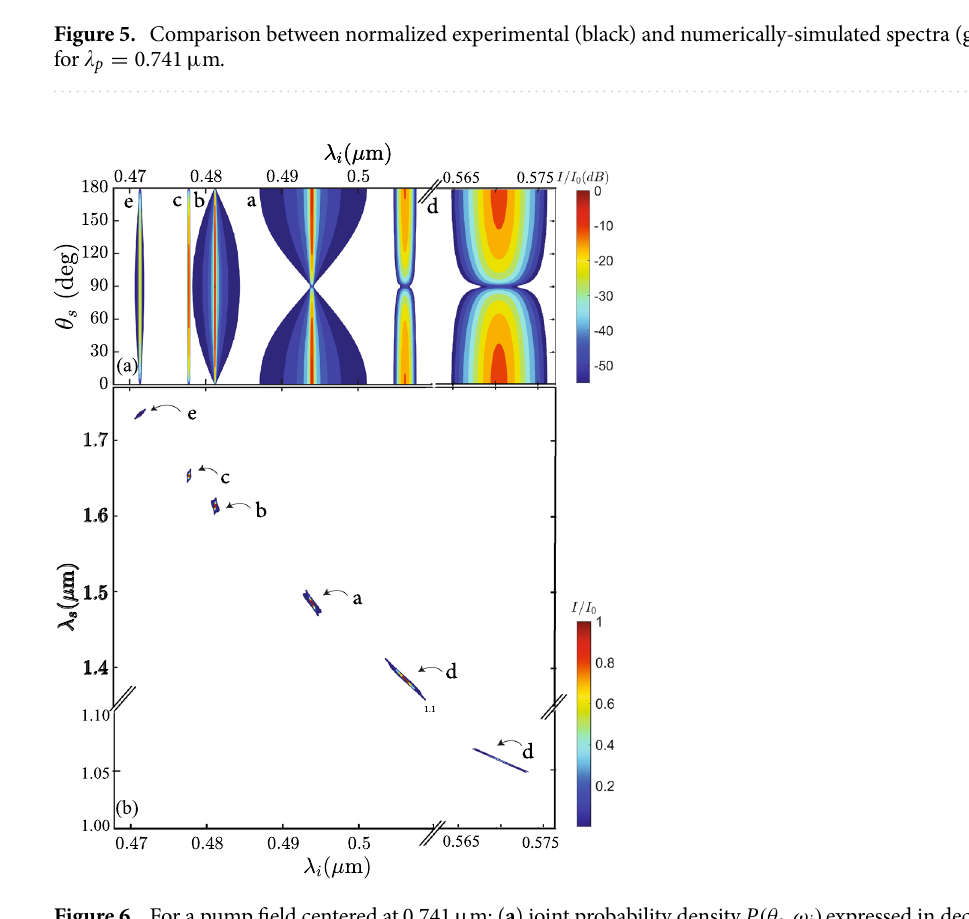
Figure 6. For a pump field centered at 0.741 µ m: ( a ) joint probability density P (θ s , ω i ) expressed in decibels and ( b ) normalized joint spectral intensity of the two-photon state, plotted as filled